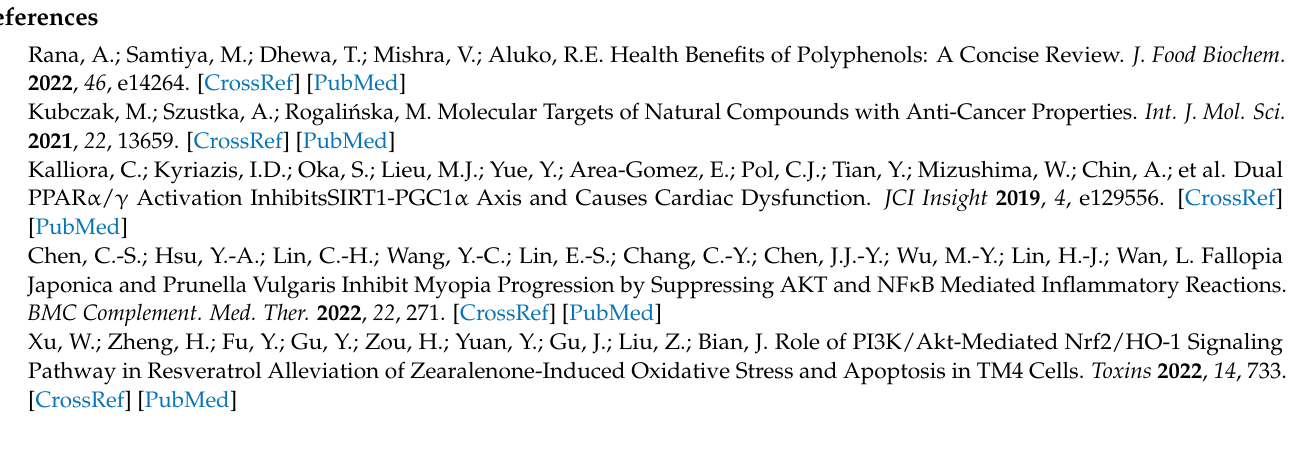
(left) and B (right); Figure S6: Dynamic cross-correlation heat map for the RES:11 β -HSD-1 complex. Correlated movements are encoded by the red color, anti-correlated movements by the blue color; Figure S7: Two-dimensional PCA scatterplots showing the projections of the displacement of the C α atoms along the first two eigenvectors for each frame of the RES:11 β -HSD-1 complex. Conformations A (blue), B (red), and C (black); Figure S8: Visualization of the PC1 (left) and PC2 (right) modes of